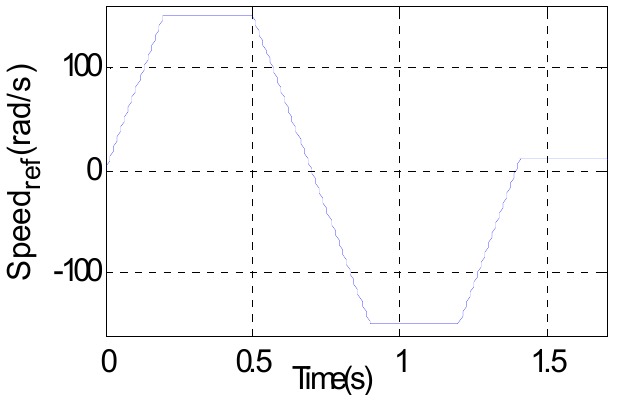
Figure 7. Reference speed.